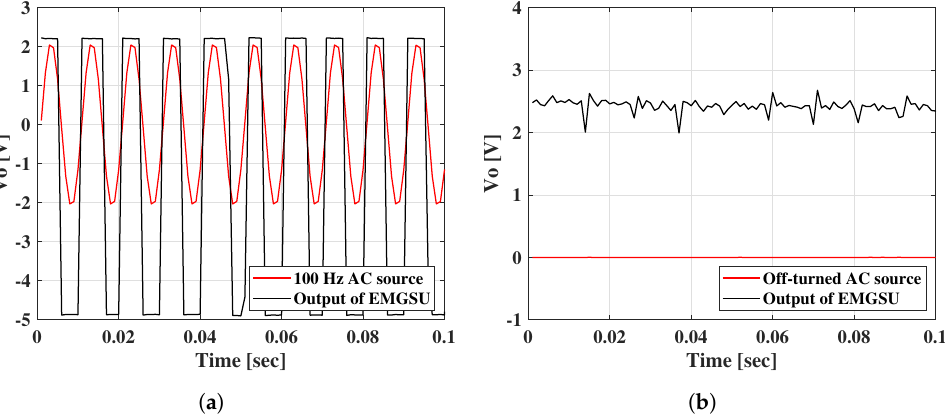
Figure 13. The solution used to eliminate the crosstalk between SSU and EMGSU: ( a ) an oscillation occurred in EMGSU channel when the 100 Hz AC source for the SSU was turned on; and ( b ) the EMG signals were picked up effectively by the EMGSU when the AC source was turned off.